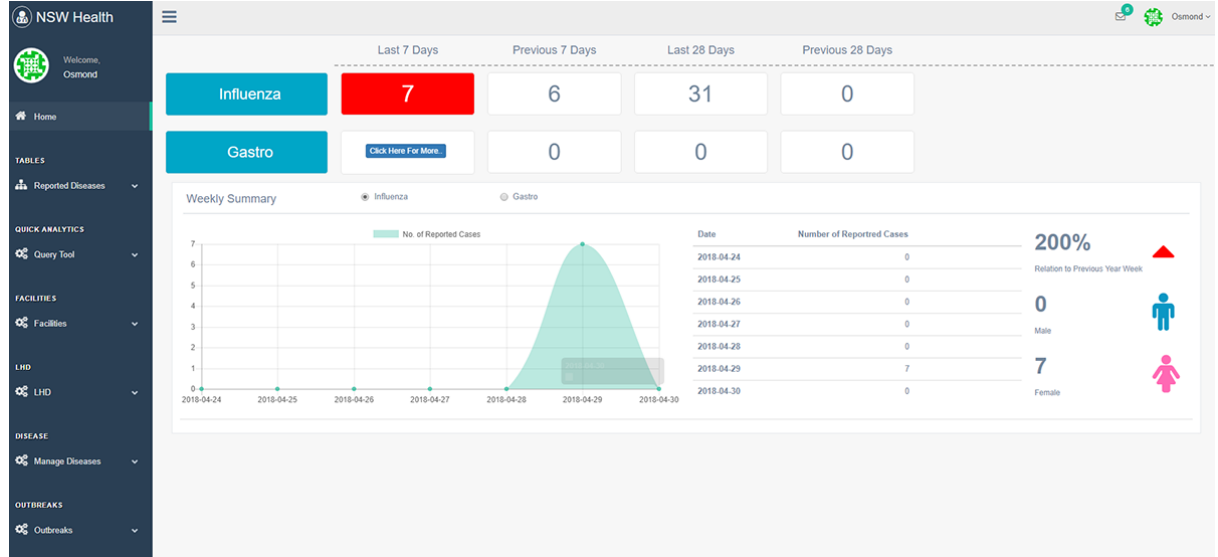
Figure 8. Daily, weekly, and monthly summary of current active